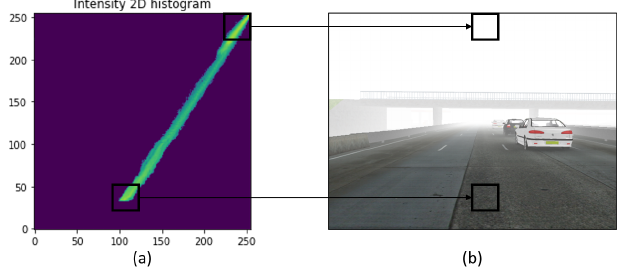
Figure 3. Foggy pixels and veil pixels intensities: ( a ) histogram showing the link between pre-veil and veil pixel intensities (mean of fifty images from the FRIDA dataset [16]), ( b ) input foggy